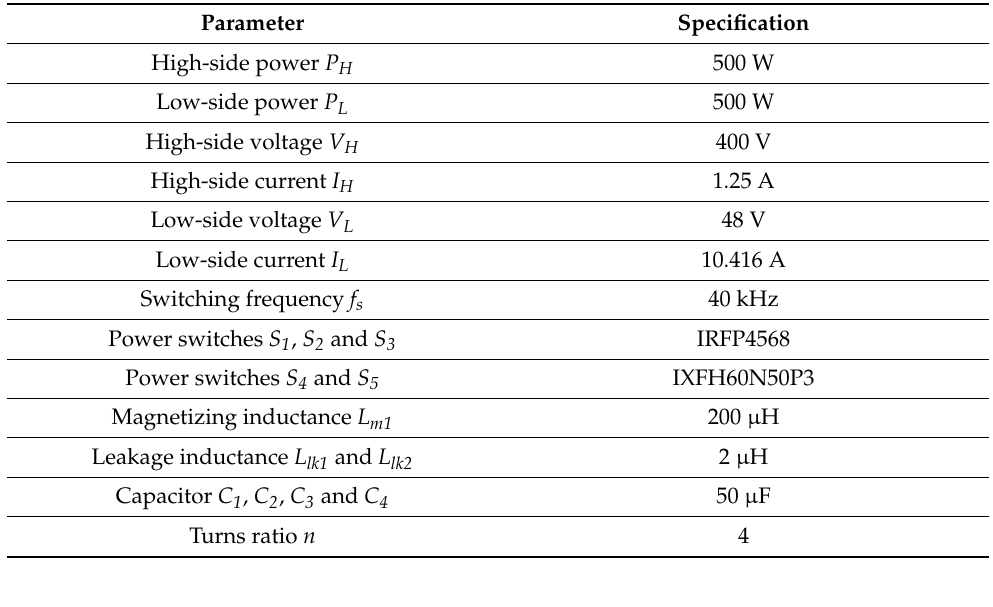
Table 1. Electrical Specifications of the Proposed Topology.